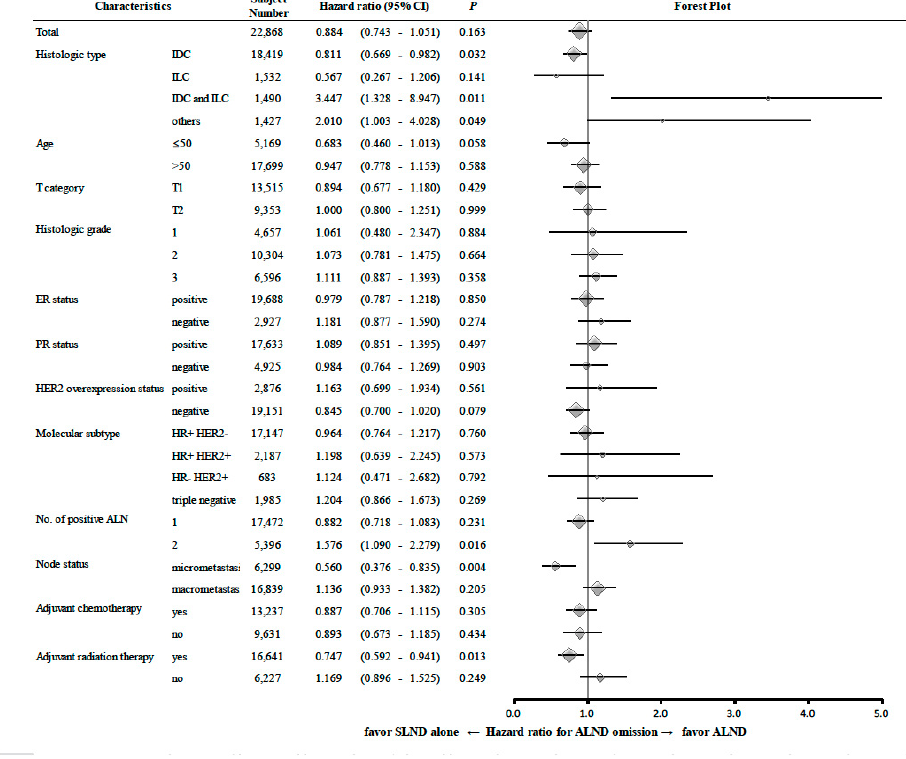
Figure 1. Breast cancer-specific mortality by type of axillary surgery. Abbreviations: axillary lymph node dissection (ALND); sentinel lymph node dissection (SLND).